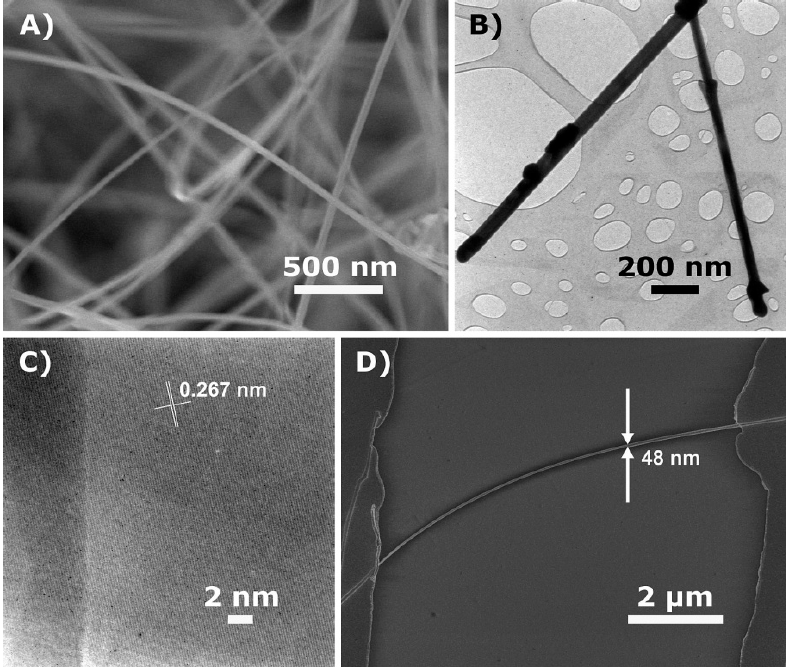
Figure 1. ( A ) SEM image of the SnO 2 nanowires forest; ( B ) TEM image of two nanowires; ( C ) HR-TEM image of a nanowire lattice; ( D ) SEM image of the sensor: a single SnO 2 nanowire bridging two metallic electrodes.